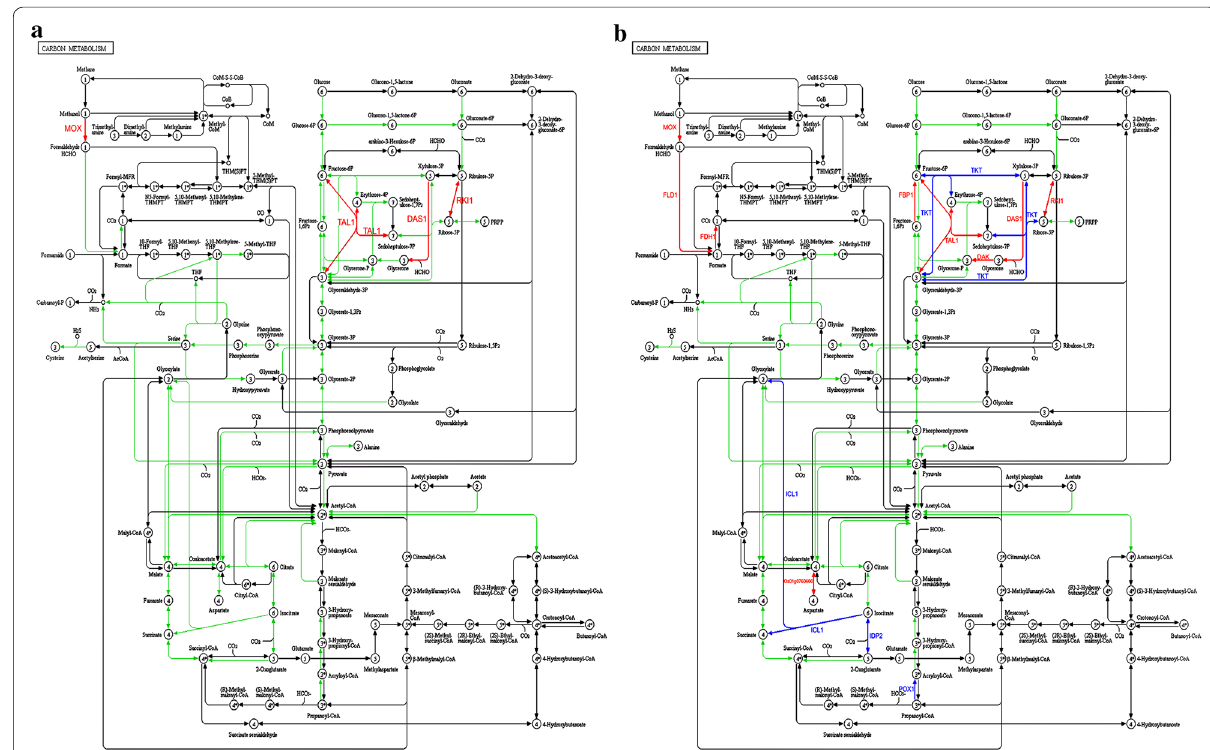
Fig. 4 Carbon metabolism of M_D vs. W_D, M_G vs. W_D ( a ) and M_M vs. M_D, M_M vs. M_G ( b ) in P. pastoris . Red words represented the up-regulated genes, and blue words the down-regulated